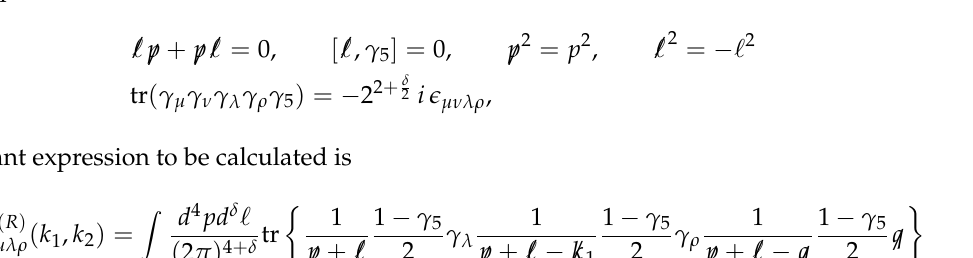
Figure 1. The Feynman diagram corresponding to (cid:101) F